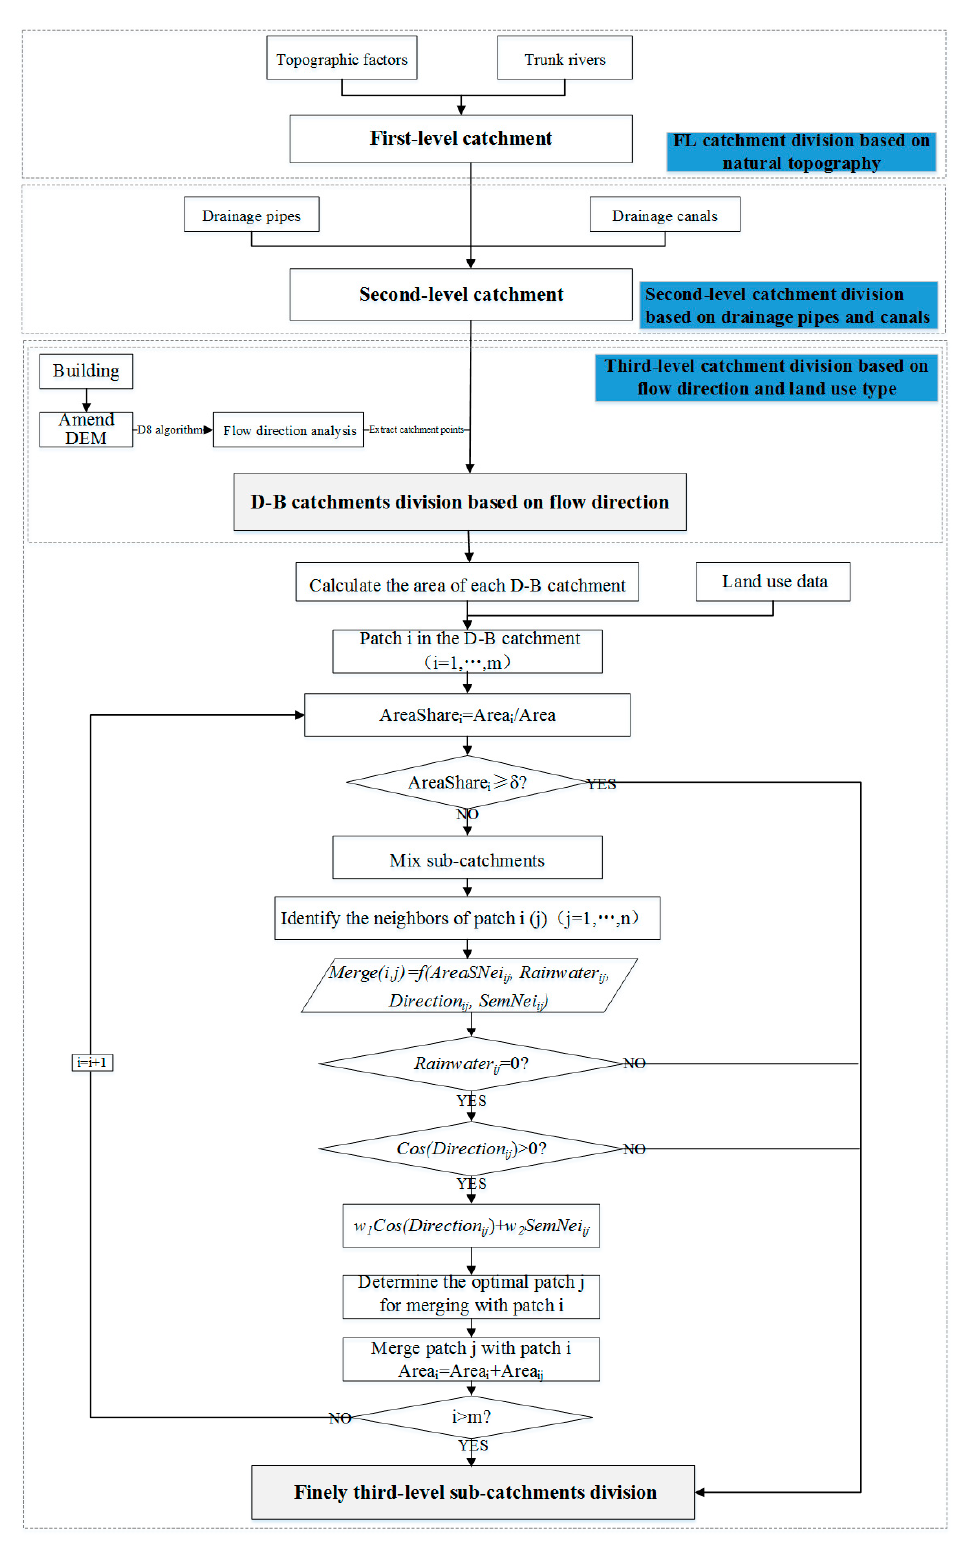
Figure 4. Flowchart of the proposed method.